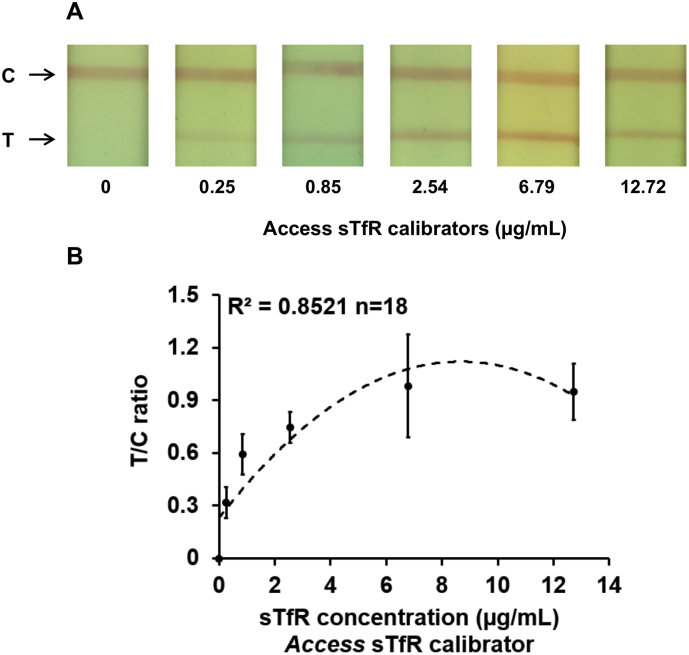
(A) Representative images of the test and control lines on the sTfR test strip for a range of sTfR concentrations of in ‘Access’ calibrators (B) Calibration curve with T/C values for a range of sTfR concentrations of in ‘Access’ calibrators.